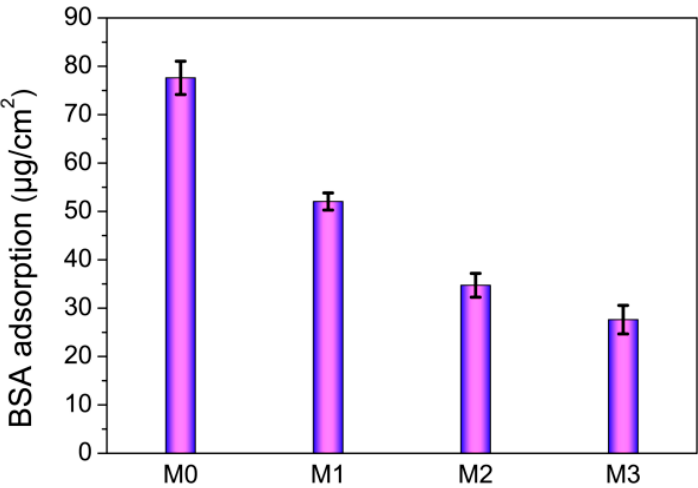
Figure 6. Amounts of protein adsorbed onto the prepared membranes.